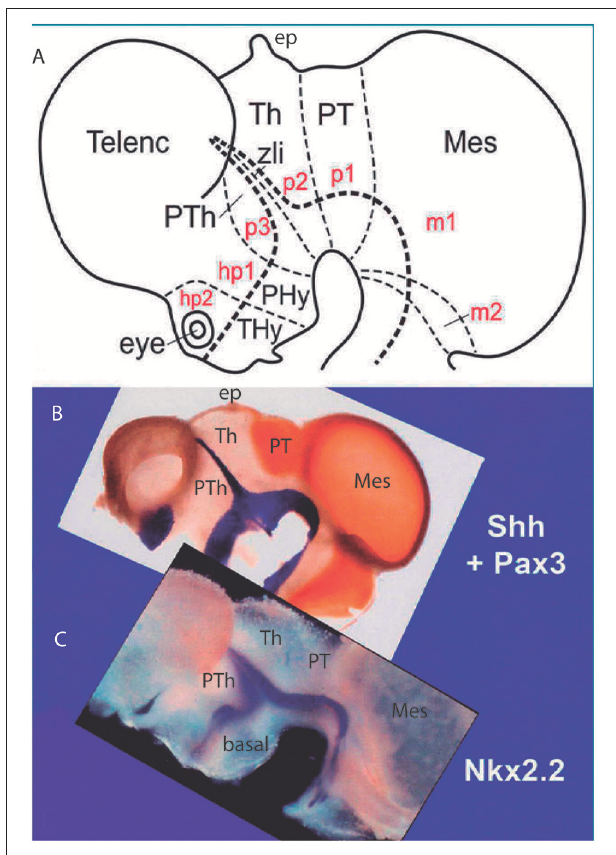
FIGURE 5 | Original images from chick embryo brains illustrating molecular support for the longitudinal axial landmarks postulated in the prosomeric model (no copyright permission required). (A) Schematic view of the prosomeric forebrain, with the mesencephalic m1 and m2 mesomeres,